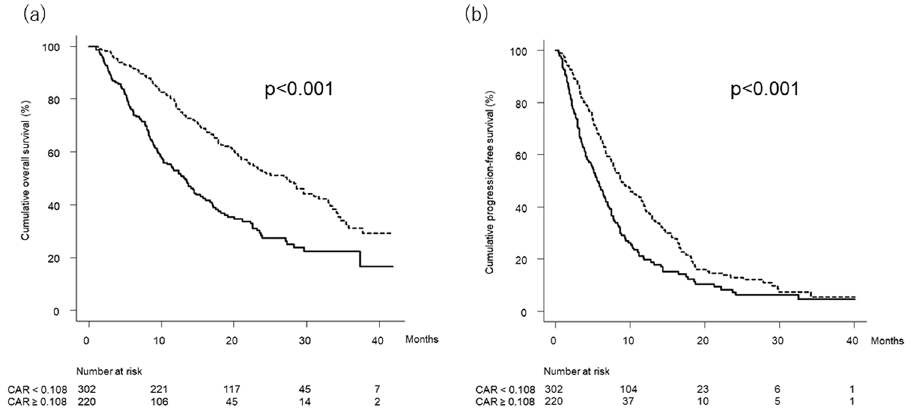
Figure 3. ( a ) Cumulative overall survival curves stratified by CAR. Cumulative overall survival at 6, 12, 18, 24, 30, and 36 months was 92.2%, 78.0%, 63.2%, 53.0%, 44.1%, and 31.1% in Patients with low CAR (< 0.108) (dotted line) and 76.0%, 53.1%, 37.6%, 27.6%, 22.3%, and 22.3% in patients with high CAR (≥ 0.108) (solid line), respectively ( p < 0.001, log-rank test). ( b ) Cumulative progression-free survival curves stratified by CAR. Cumulative progression-free survival at 3, 6, 9, 12, 15, and 18 months was 87.0%, 67.0%, 49.4%, 39.2%, 29.9%, and 20.9% in patients with low CAR (< 0.108) (dotted line) and 70.5%, 47.7%, 29.2%, 19.7%, 15.2%, and 12.4% in patients with high CAR (≥ 0.108) (solid line), respectively ( p < 0.001, log-rank test). CAR, C-reactive protein to albumin